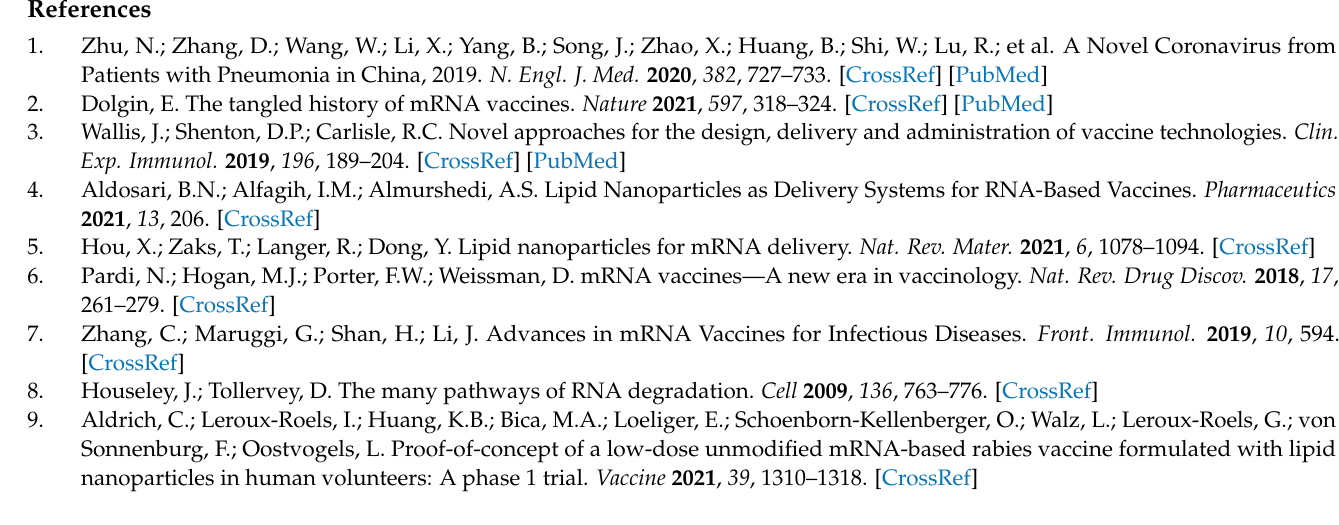
Table S2. Dose Volumes Administered. Table S3. Hematology parameters. Table S4. Coagulation parameters. Table S5. Clinical Chemistry Parameters. Table S6. Urinalysis Parameters. Table S7. Tis- sue collection and organ weights. Table S8. Test article-related clinical pathology findings. Figure S1. Body